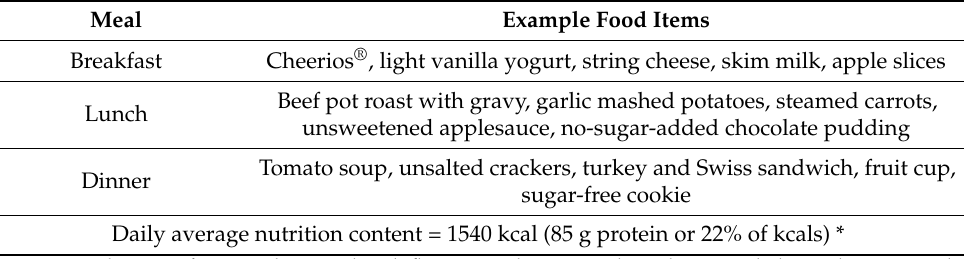
Table 1. Example patient menu for the ‘core four’ meal option with hot items. The ‘core four’ meal was the most commonly prescribed therapeutic meal among Javits New York Medical Station